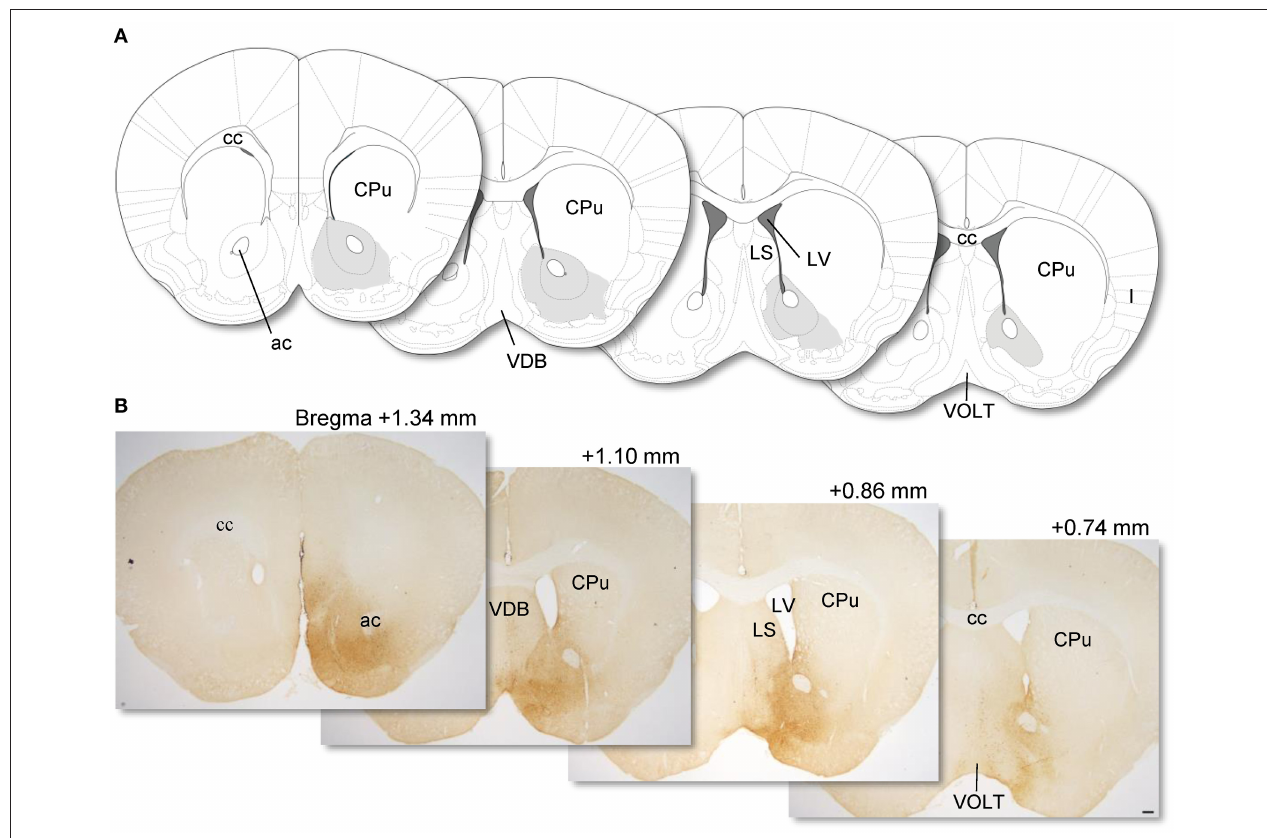
FIGURE 1 | Coronal sections from the mouse brain atlas of Franklin and Paxinos (2007) showing the position of the NAc (A) . Representative photomicrographs showing the site of mCherry expression in the NAc (dark brown areas) in AAV-FLEX-mCherry-injected NPY-Cre mice (injection into the NAc) (B) . Numerical values on each photomicrograph show distance from bregma (mm). Scale bar, 100 µ m. ac, anterior commissure; cc, corpus callosum; CPu, caudate putamen; I, insular cortex; LS, lateral septum; LV, lateral ventricular; VDB, nucleus of the vertical limb of the diagonal band; VOLT, vascular organ of the lamina